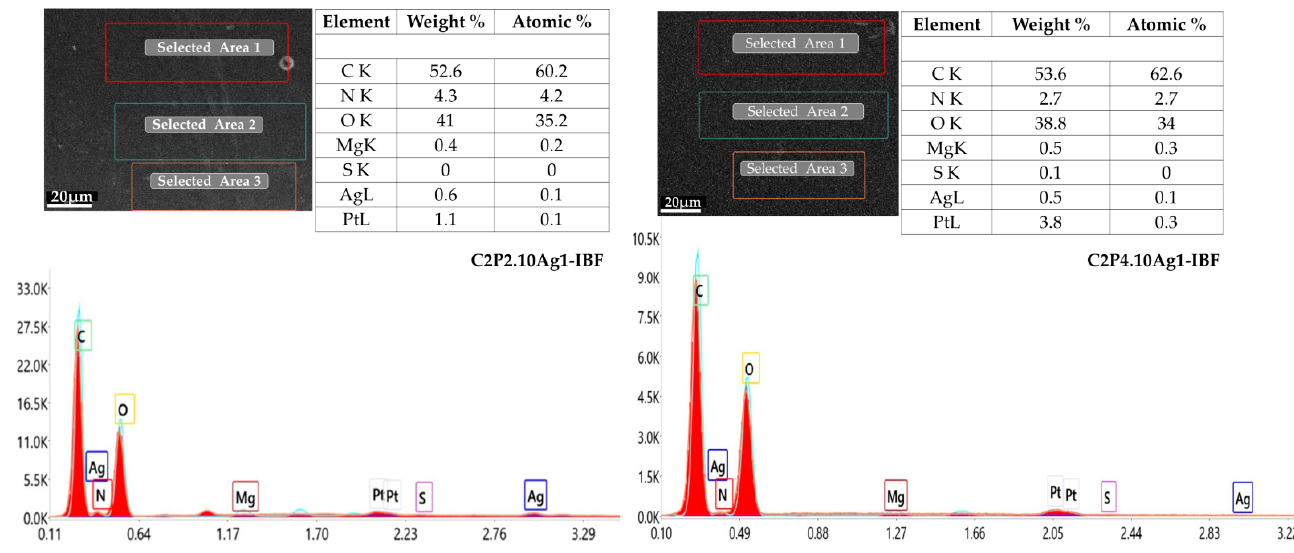
Figure 6. EDAX spectrum of composite films (scale bar-20 µ m).